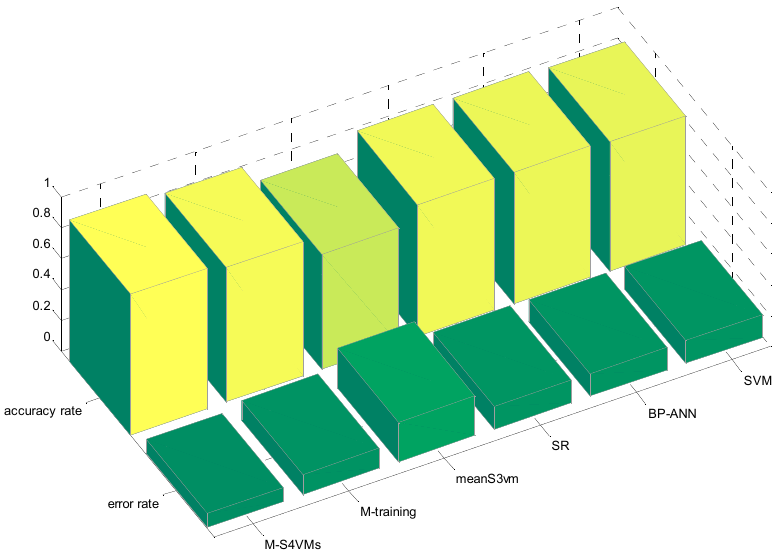
Figure 9. Total accuracy rate of the four semi-supervised algorithms.